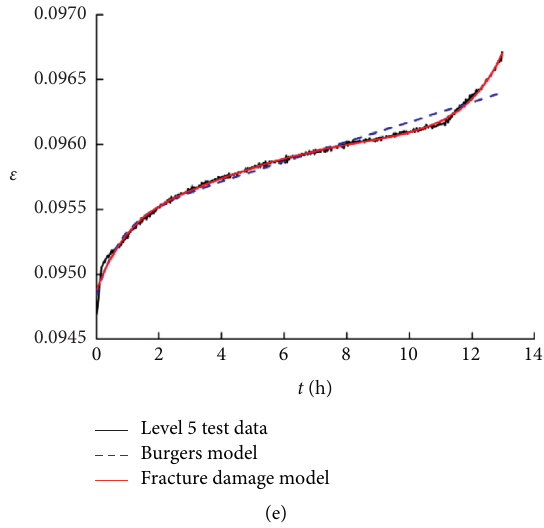
Figure 10: Comparison between test data and model fitting